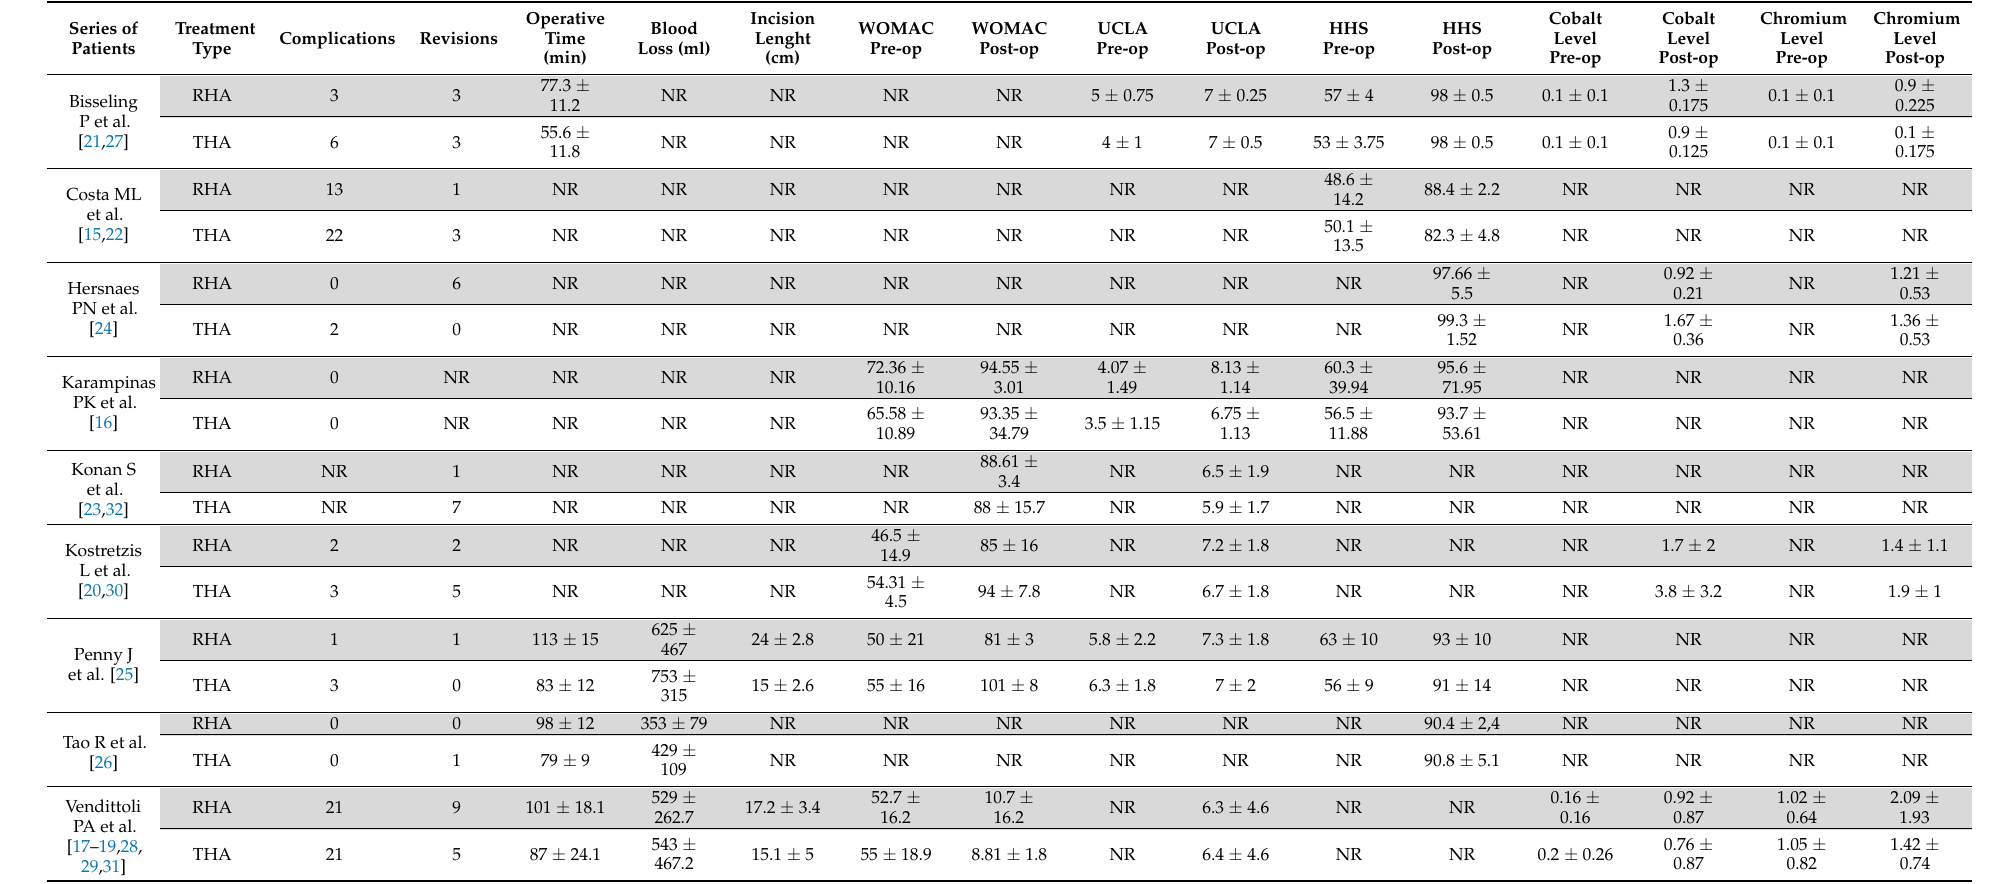
Table 2. Main findings of the 9 patient series